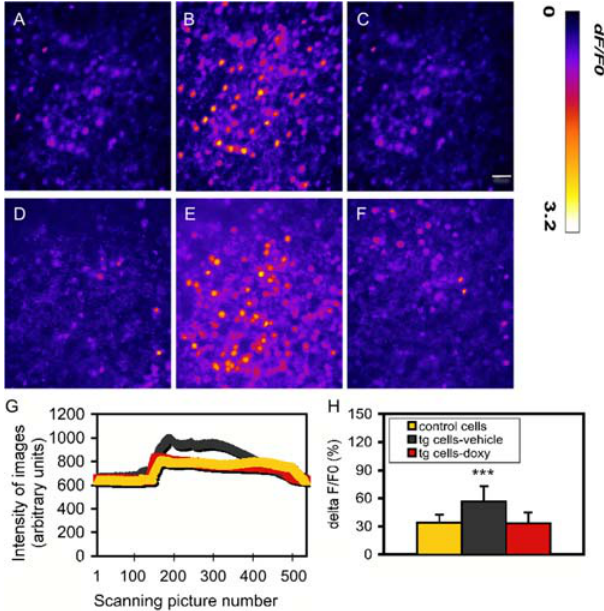
Figure 3. Enhanced NMDAR function in cerebellar granule cells of tg mice. A–F. Representative Ca 2 + imaging microphotos from before the NMDA (0.1 m M together with glycine 10 m M) application (A and D), the maximal [Ca 2 + ] I responses (B and E), and returned to the basal level (C and F) in control cell (A–C) and tg cell (D–F), respectively. G. Representative time courses for the changes of [Ca 2 + ] i in single granule cells of three groups of mice tested during a typical 5-minute experimental period, during which 500 image frames were collected. H. Quantitative analysis of [Ca 2 + ] i . Data is expressed as mean 6 SD. ***, p , 0.001, post-hoc analysis with Fisher’s PLSD test in comparison between tg neurons-treated with vehicle and control neurons and between tg neurons-treated with vehicle and tg neurons-treated with doxy, respectively. Bar in F represents 20 m m. Data are expressed as mean 6